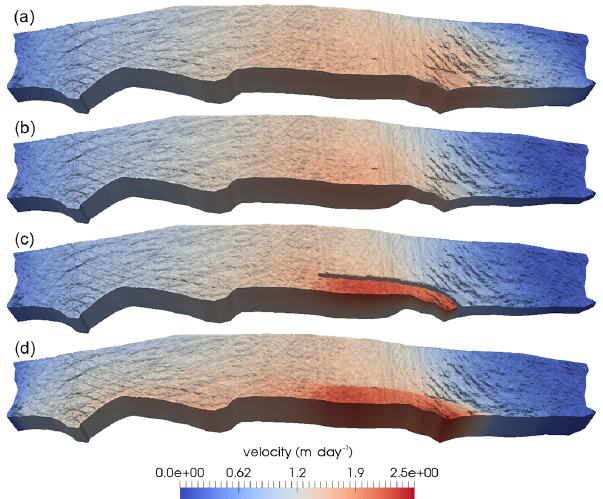
Figure 7. Magnitude of the modelled velocity field after the first (a) , the second (b) and the third (c) optimization, i.e. (a) corresponds to the original setup with optimal parameters (E,C,α) , (b) accounts for the optimal bump height on the bed while (c) accounts for the optimal crack depth. For the sake of comparison, (d) displays the measured UAV-inferred velocity field on the surface.